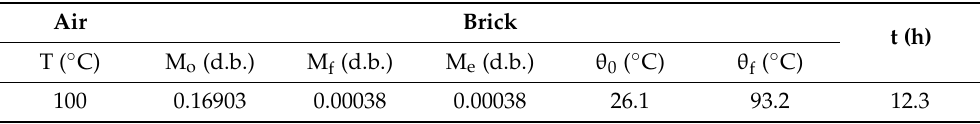
Table 4. Experimental parameters of air and brick for drying test [8].